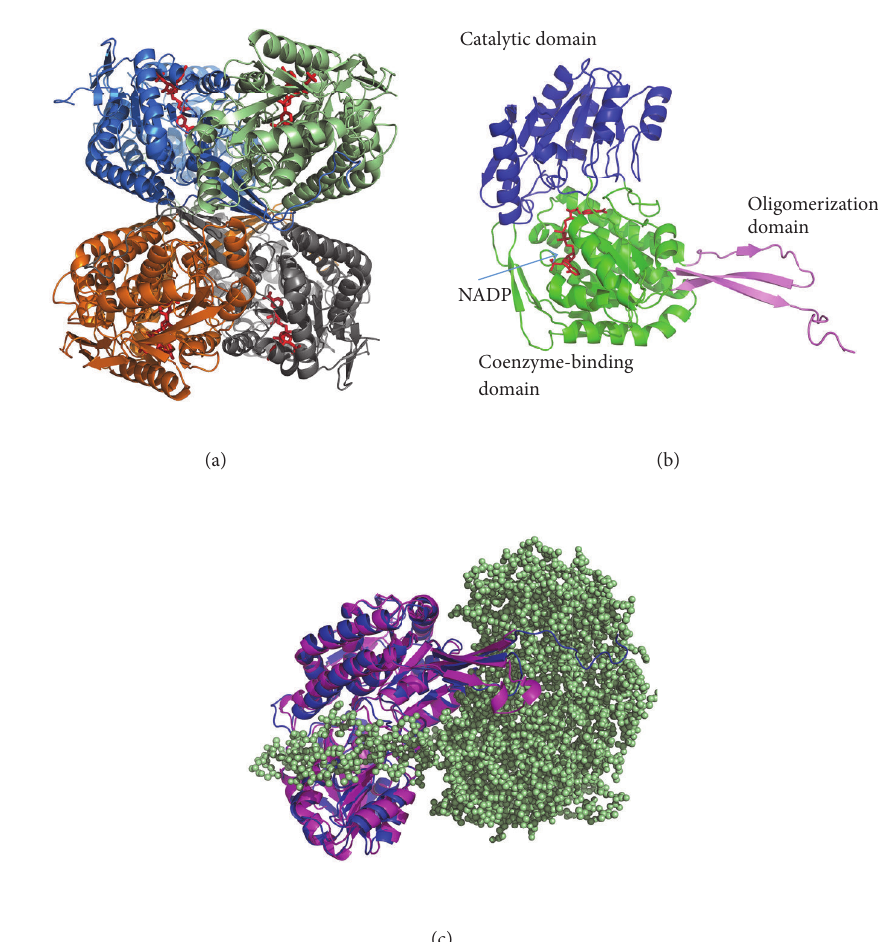
Figure 3: Overall structure of AlDHPyr1147. The coenzyme is in red. (a) The structure of the tetramer. The subunits that form the tetramer are in blue, grey, brown, and pale green. (b) The structure of the subunit. The catalytic, coenzyme-binding, and oligomerization domains are in blue, green, and magenta, respectively. (c) The superposition of the subunit of aldehyde dehydrogenase from Streptococcus mutants , PDB entry 2EUH (magenta), and the subunit of AlDHPyr1147 (blue). The second subunit of AlDHPyr1147 that forms a dimer with the first subunit is shown as pale green